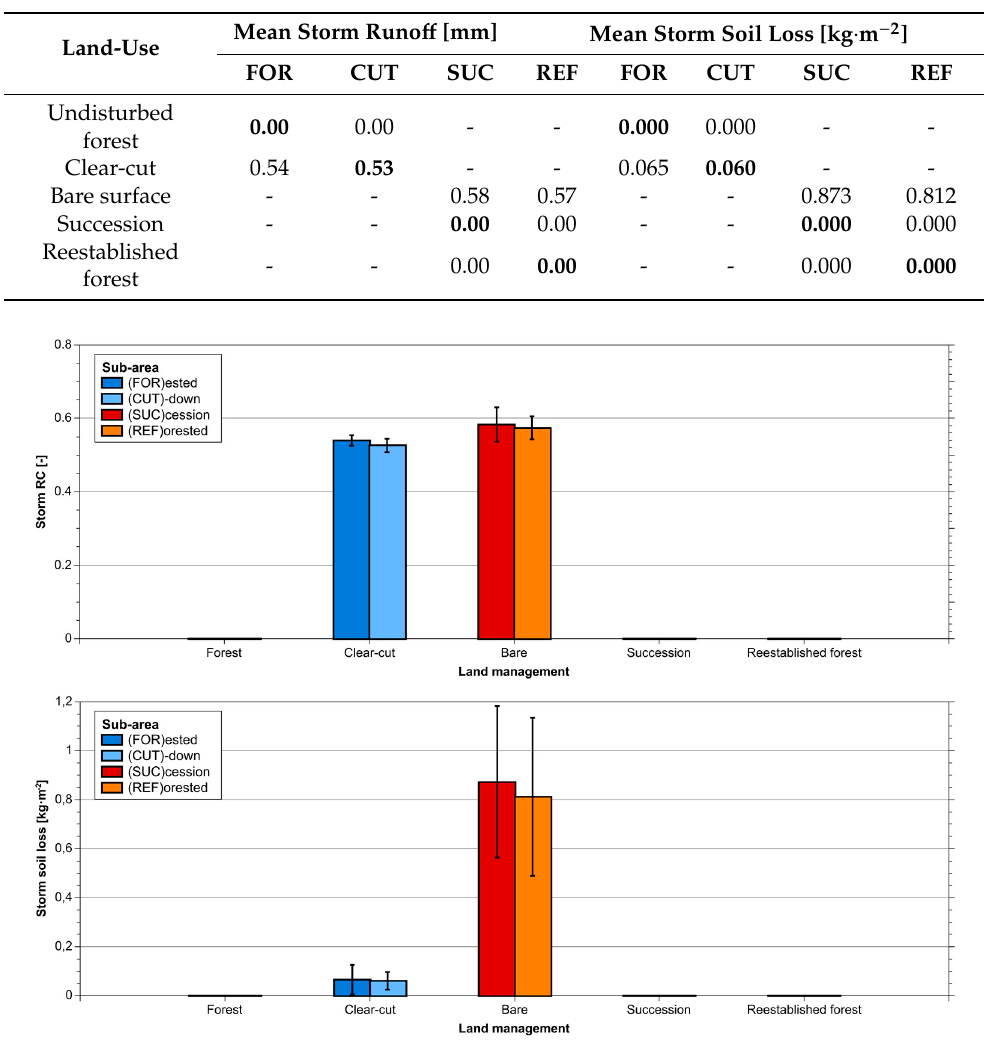
Figure 14. Modeling results for land management shifts on standardized slope, storm runoff coefficient (RC) and soil loss. Y-error indicates standard deviation, blue columns indicate undisturbed soils, red columns indicate disturbed soils.